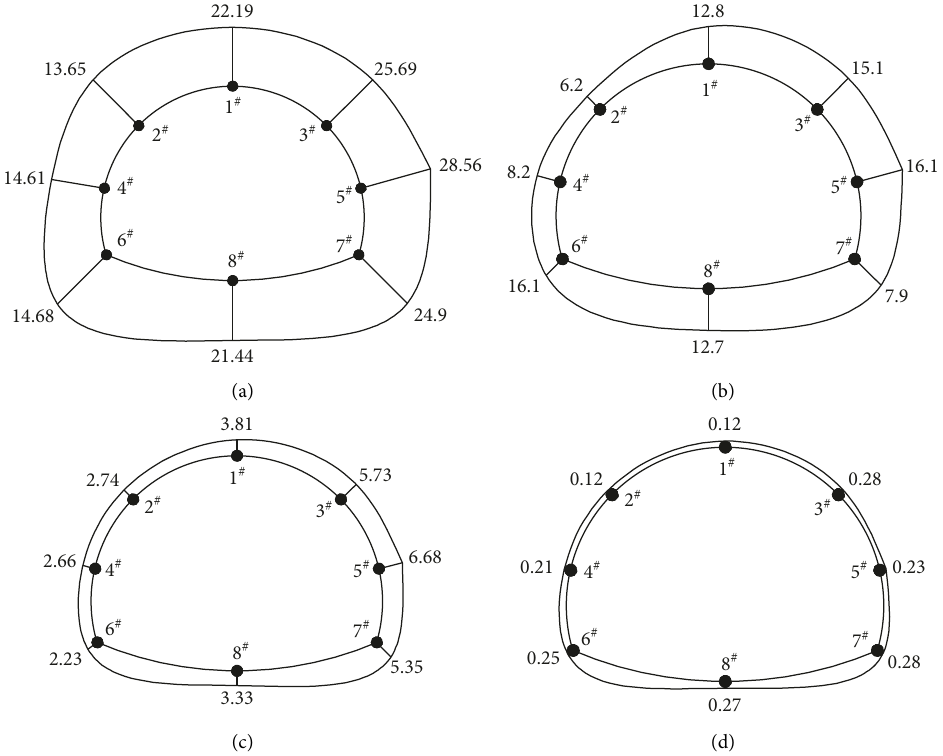
Figure 15: Tunnel vibration velocity envelope diagram. (a) Tunnel clear distance 0.15D, (b) tunnel clear distance 0.5D, (c) tunnel clear distance D, and (d) tunnel clear distance